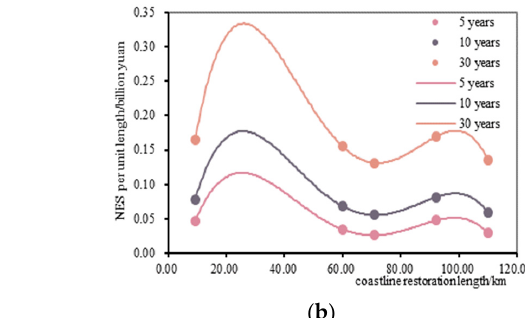
Figure 5. The correlation scatter plot of costs (including total initial cost and management cost) and value of ecosystem services (VES).